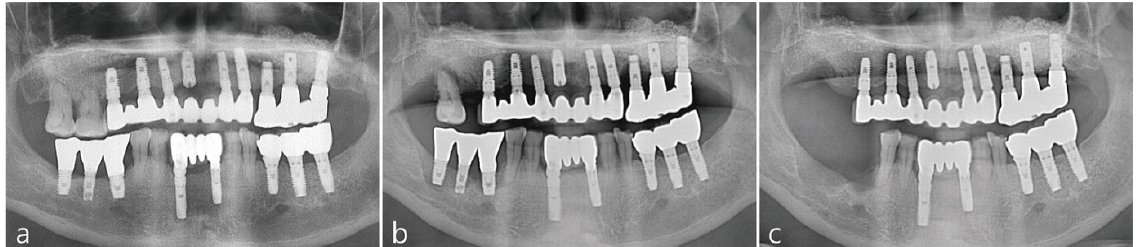
Figure 1. ( a ) Pre-operative panoramic radiograph ( b ) Panoramic radiograph taken after the extraction of the maxillary right first molar ( c ) Panoramic radiograph taken after the extraction of the maxillary right second molar and removal of right posterior implants.